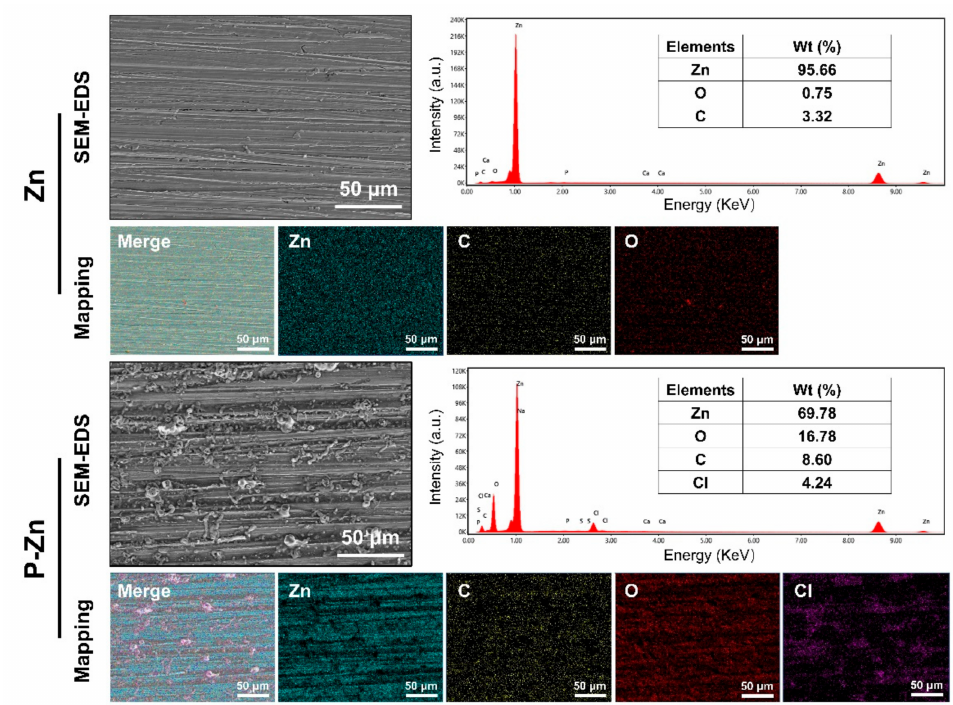
Figure 2. Surface morphology and chemical composition of Zn and P-Zn. Representative SEM images (scale bar = 50 µ m, magnification 500 × ). EDX measurement is indicated by the whole area, showing the elemental composition (energy range between 0–10 keV). EDS mapping showed the elemental